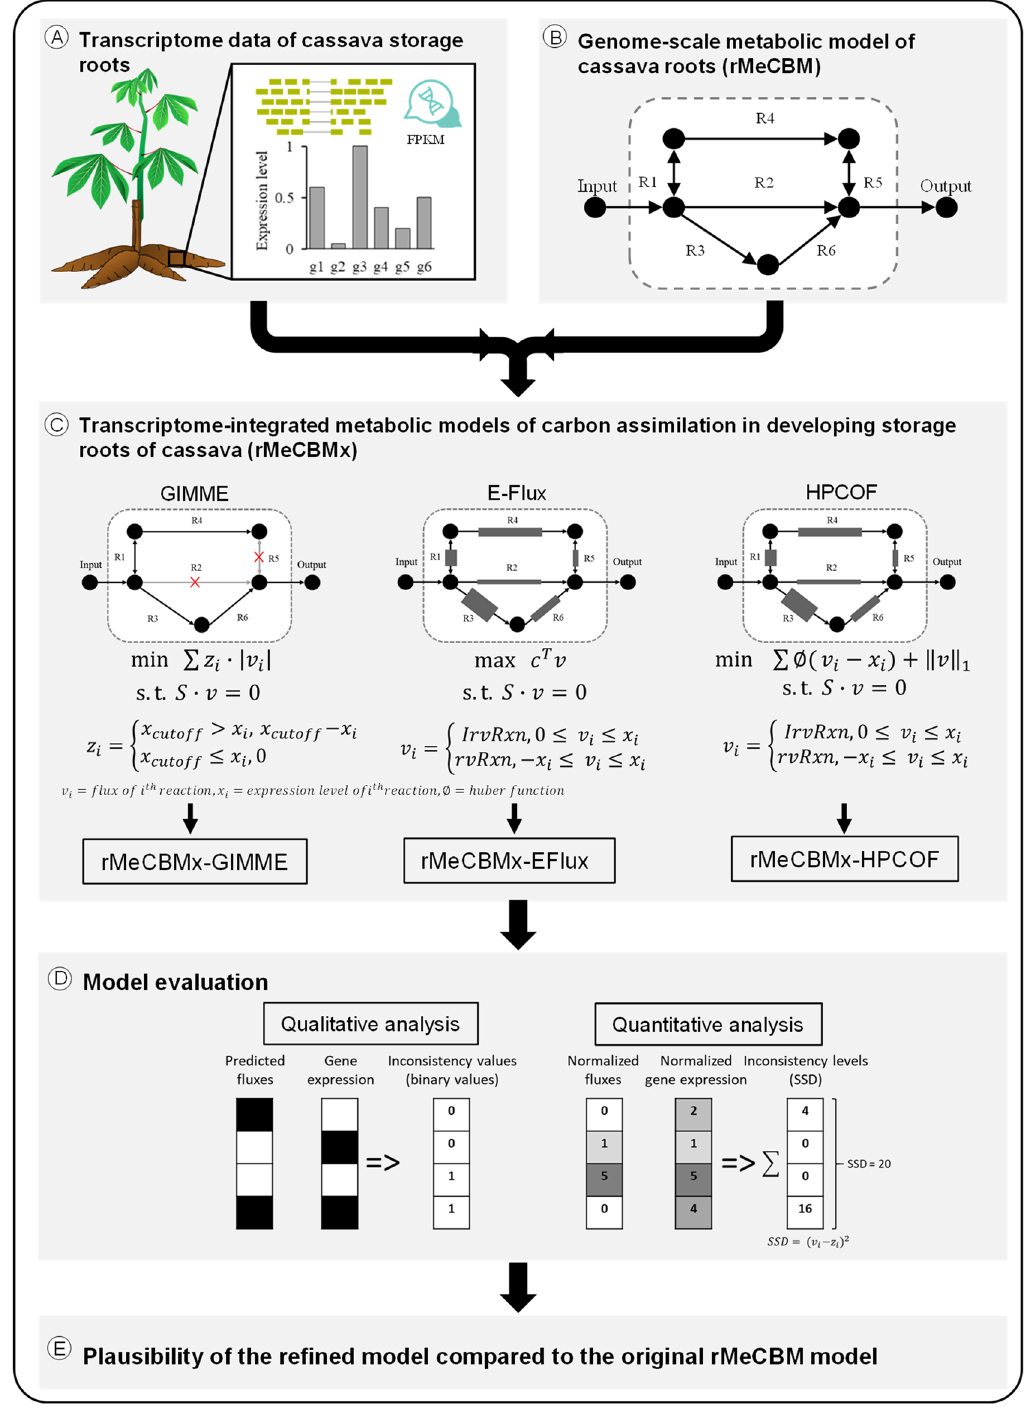
Figure 1. Overall methodology. ( A ) Transcriptome data analysis of gene expression in developing storage roots of cassava. ( B ) Genome-scale metabolic model of cassava storage roots, rMeCBM, obtained from Chiewchankaset et al . 16 . ( C ) Development of transcriptome-constrained GSMM models through GIMME, E-Flux, and HPCOF methods. Metabolic fluxes of each reaction were constrained by the relative expression level of the highest expressed genes responsible for the reaction. ( D ) Evaluation of model performance based on the consistency of predicted fluxes with gene expression levels, both qualitatively and quantitatively. ( E ) Plausibility testing of the transcriptome-constrained GSMM model by simulation of storage root growth of the high- yielding cultivar CMC-9, sensitivity analysis, and analysis of the consistency of predicted flux distribution with the gene expression